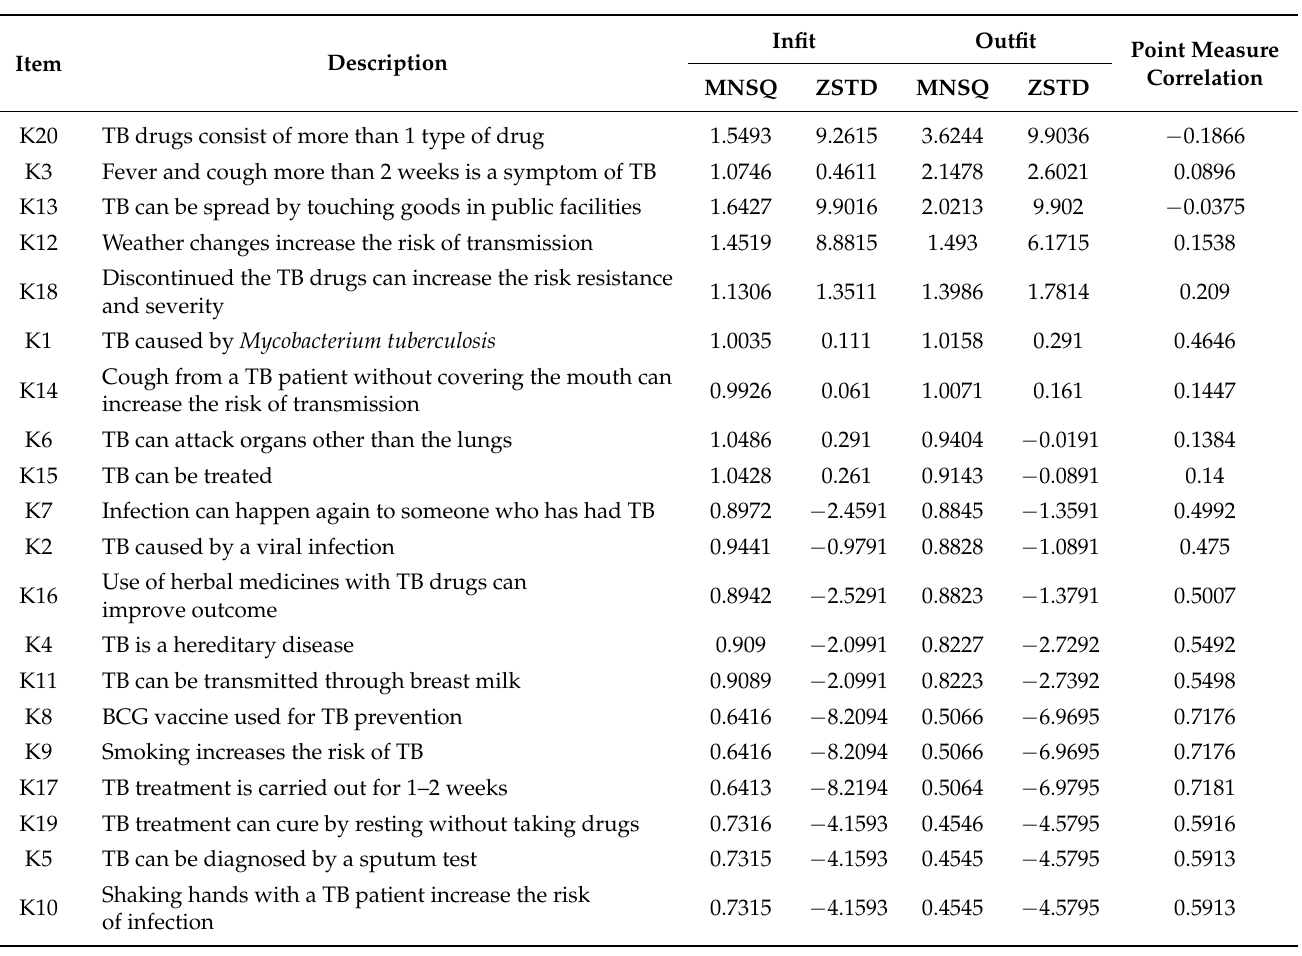
Table 2. Item fit statistics for KATUB-Q items from the dichotomous Rasch analysis (n =